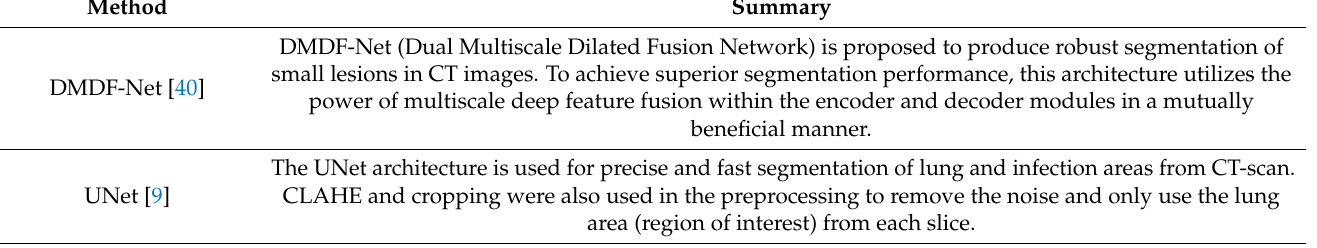
Table 1. A summary of the recently published studies on image segmentation using the same dataset. Method